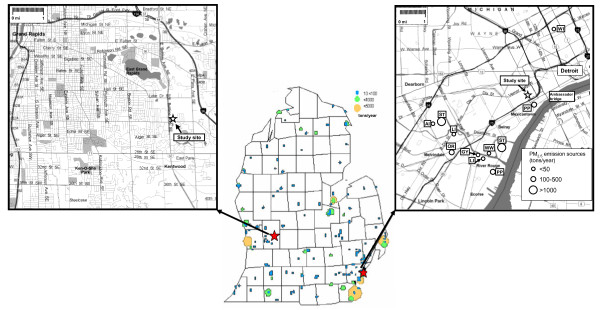
Exposure study sites. Maps of Grand Rapids (left) and southwest Detroit, MI (right) showing the locations of the study sites and major industrial sources for PM2.5 (USEPA-Air Data NET, 1999) (AI: auto industries, CE: cement industries, GY: gypsum industries, LI: lime industries, OR: oil refineries, PP: coal-fired power plants, ST: iron/steel industries, WI: waste incinerator, WW: waste water treatment and sludge incinerator).